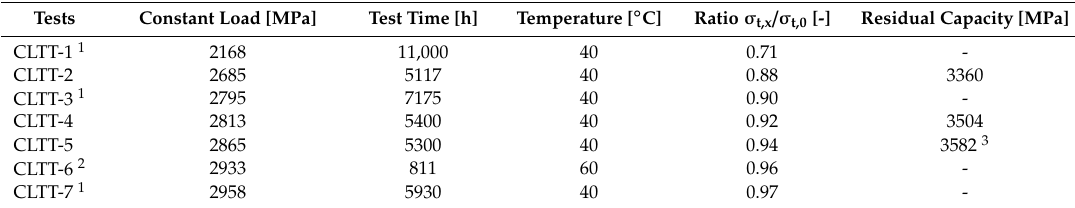
Table 3. Overview of the long-term durability tests.